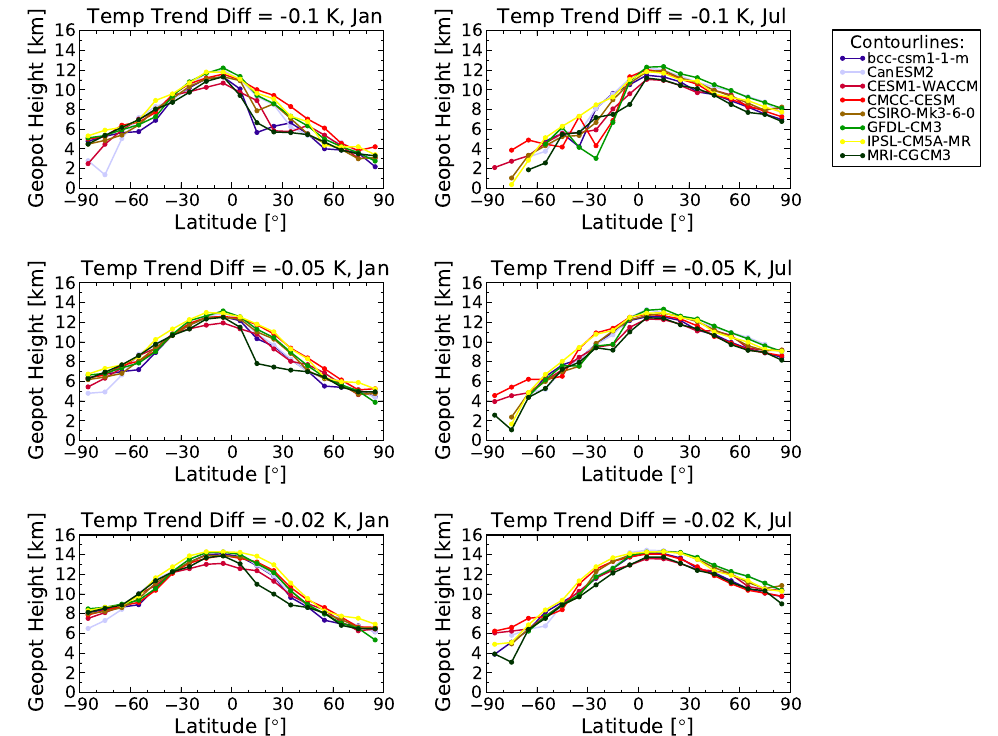
Figure 10. Latitudinal and altitudinal dependence of differences between physical and dry temperature trends for the “max 8” CMIP5 models, for January (left) and July (right), for − 0 . 1 K decade − 1 (top), − 0 . 05 K decade − 1 (middle) and − 0 . 02 K decade − 1